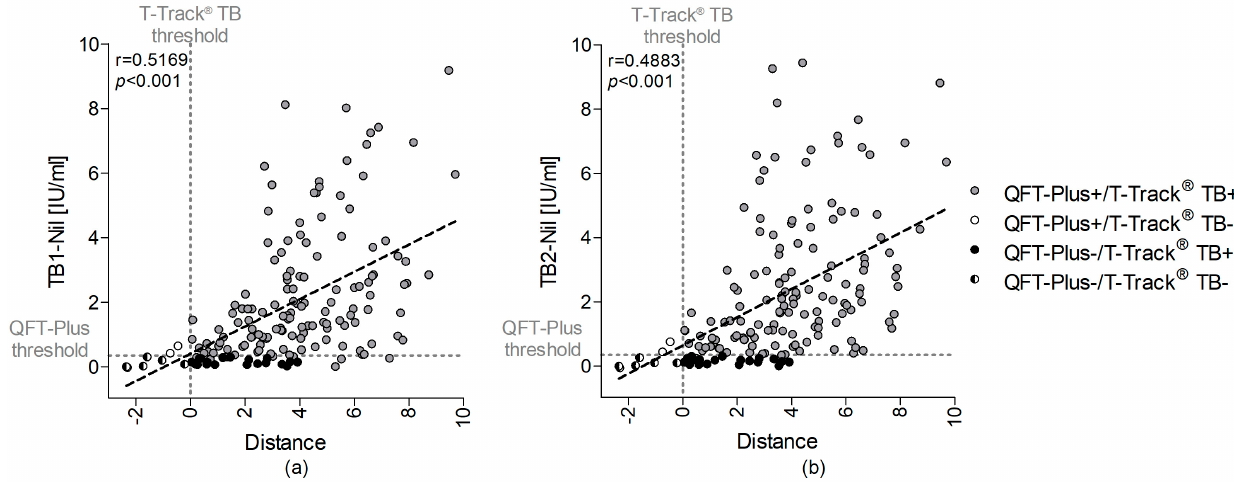
Figure 5. Correlation analysis between QFT ‐ Plus results for ( a ) TB1 ‐ Nil or ( b ) TB2 ‐ Nil (IU/mL) and T ‐ Track ® TB distance values for 164 donors with active TB. The 19 TB patients misclassified by QFT ‐ Plus are shown as black circles, the 2 patients misclassified by T ‐ Track ® TB are depicted as white circles and the 6 patients falsely classified by both tests in black–white circles. TB patients correctly classified with both tests are depicted in grey. The vertical dashed line depicts the T ‐ Track ® TB classification threshold defining the T ‐ Track ® TB assay result (“positive” vs. “negative”), and the horizontal dashed line represents the QFT ‐ Plus threshold. Regression analysis was performed by linear correlation. QFT ‐ Plus+/ ‐ , positive/negative QuantiFERON ® ‐ TB Gold Plus test result; T ‐ Track TB+/ ‐ , positive/negative T ‐ Track ® TB test result.